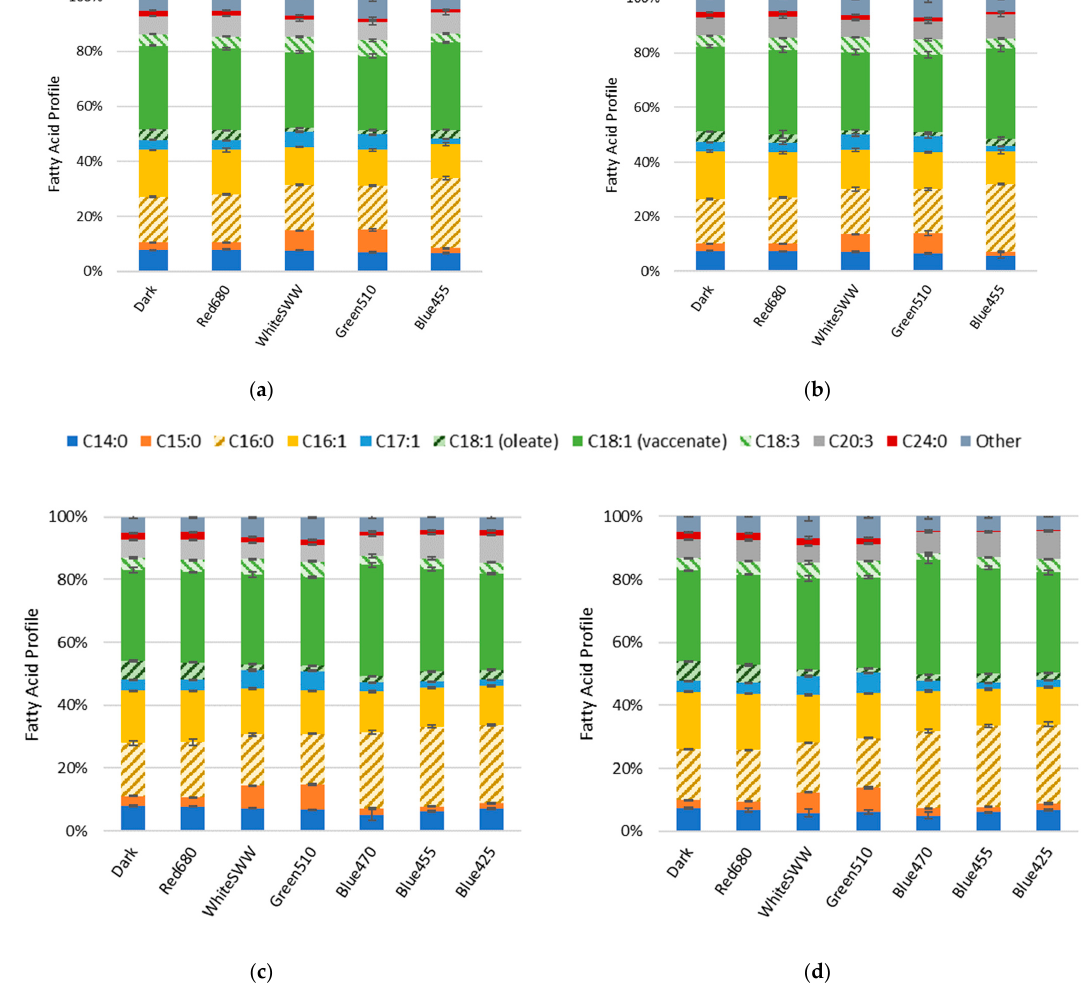
Figure 3. Fatty acid profiles of R. erythropolis at 236 W s − 2 illumination with white (standard warm white), blue (425, 455 and 470 nm), green (510 nm) and red (680 nm) light as well as a control (n = 3). “Other” constitutes fatty acids with a representation below 2% of total fatty acid content ( w / w ), and include C14:1, C17:0, C18:0, C20:1, C20:5, C22:1. ( a ) Fatty acid profile collected at 40 h, ( b ) at 122 h, ( c ) at 40 h, ( d ) and at 94 h.